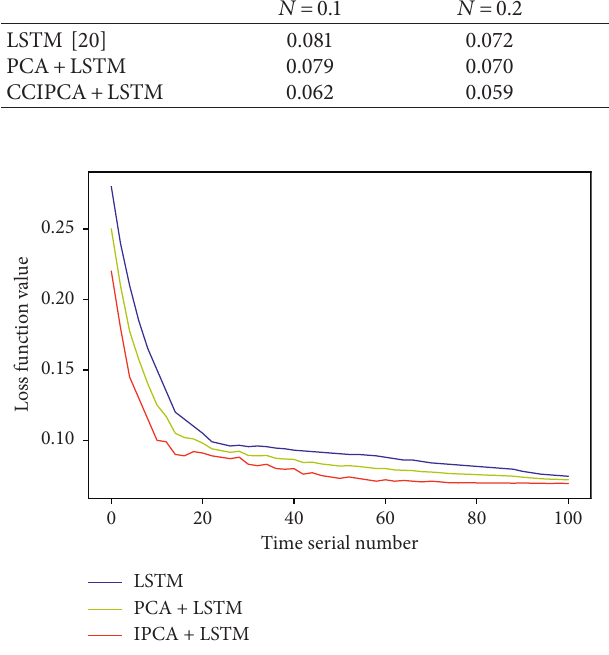
Figure 4: Loss function curve of training set and test